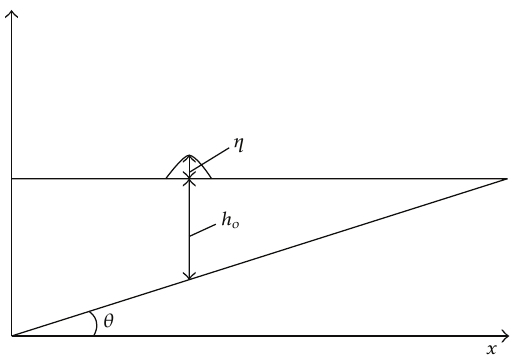
Figure 2: Schematic diagram of a solitary wave propagating over a mild slope